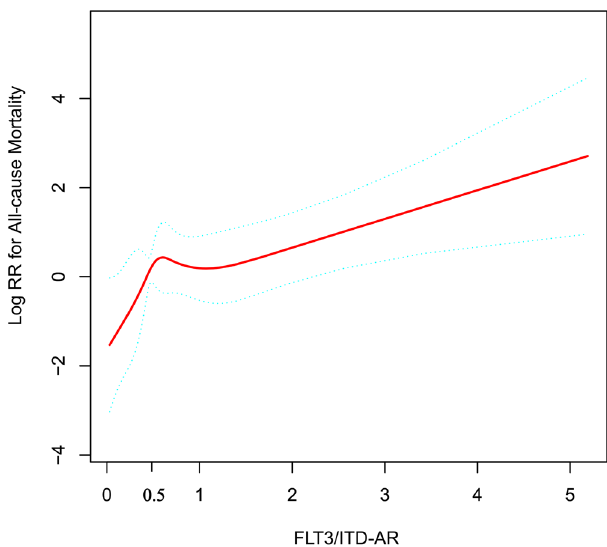
Fig. 2 Restricted cubic spline of the association of FLT3/ITD AR with risk of all-cause mortality. The resulting fi gures show the predicted log(relative risk) in the y -axis and the FLT3/ITD AR in the x-axis. Abbreviations: AR allelic ratio.The bold lines, upper boundaries and lower boundaries of notches represent the mean, max and min values. Data were expressed as means ± SD. Source data are provided as a Source Data fi le.